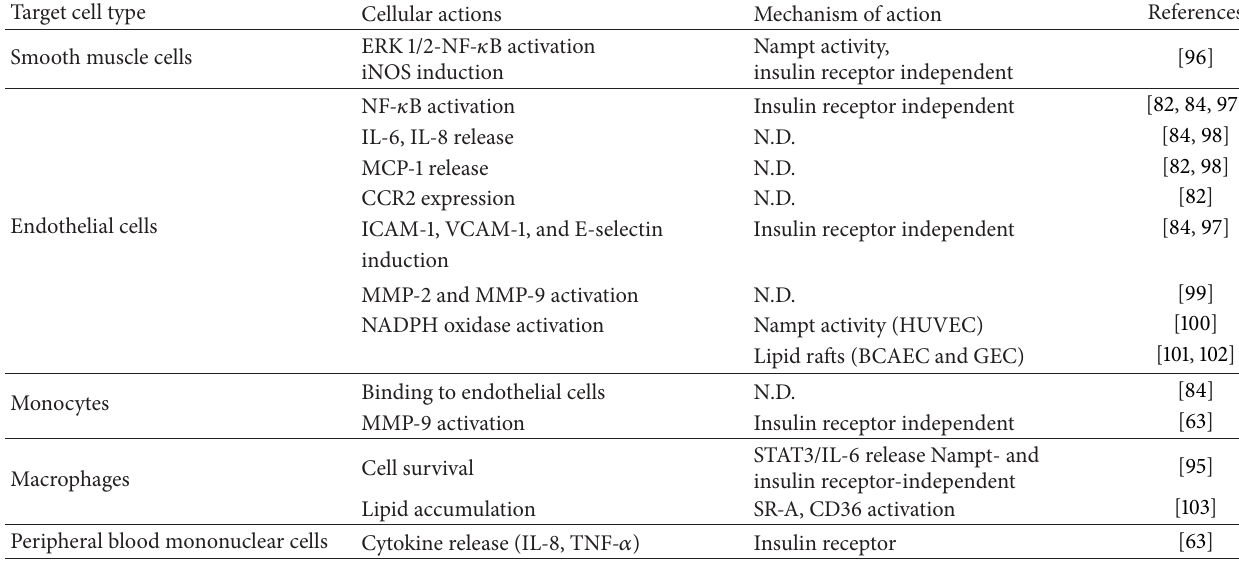
N.D.: not determined. BCAEC: bovine coronary artery endothelial cells, CCR2: chemokine receptor type 2, CD36: cluster of differentiation 36, ERK 1/2: extracellular signal-regulated kinase 1/2, GEC: glomerular endotelial cells, HUVEC: human umbilical vein endothelial cells, ICAM-1: intercellular adhesion molecule-1, IL: interleukin, MCP-1: monocyte chemotactic protein-1, MMP: matrix metalloproteinase, NF- 𝜅 B: nuclear factor- 𝜅 B, iNOS: inducible nitric oxide synthase, SR-A: scavenger receptor-A, STAT3: signal transducer and activator of transcription 3, TNF- 𝛼 : tumor necrosis factor- 𝛼 , and VCAM-1: vascular cell adhesion